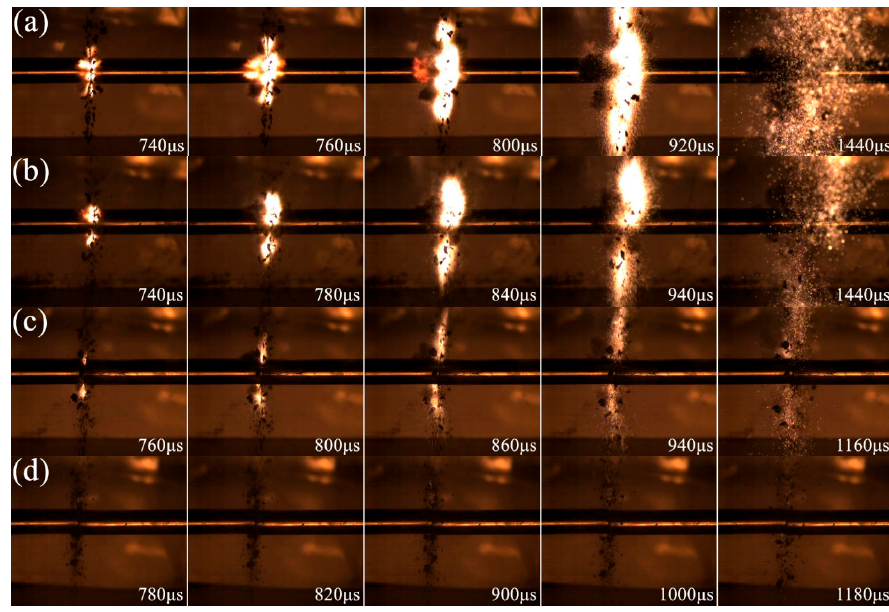
Figure 12. Video frames of PTFE/Ti/W composites with different W content under the similar strain rates: ( a ) 68PTFE/32Ti at 6400 s − 1 ; ( b ) 47PTFE/23Ti/30W at 6380 s − 1 ; ( c ) 34PTFE/16Ti/50W at 6020 s − 1 ; ( d ) 20PTFE/10Ti/70W at 6200 s − 1 .